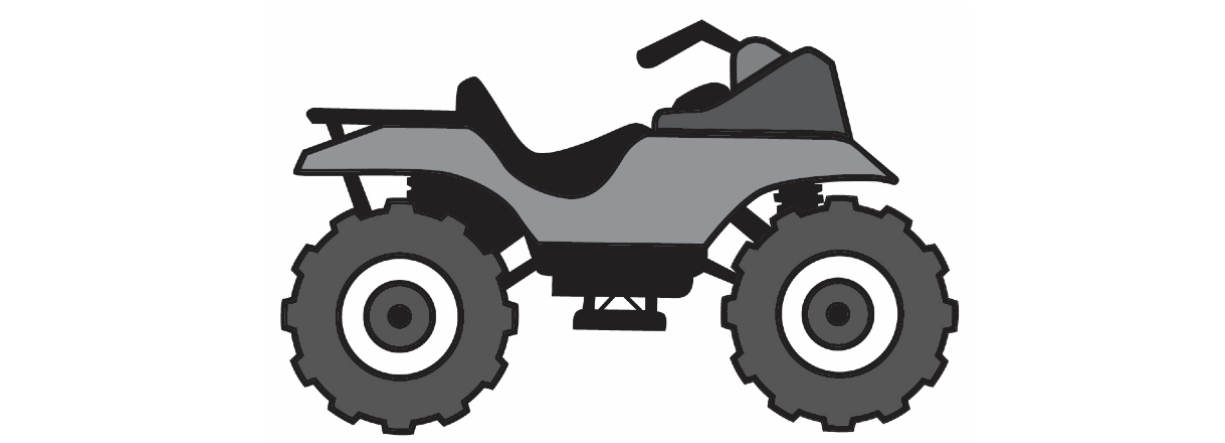
Figure 1. All-terrain vehicle.